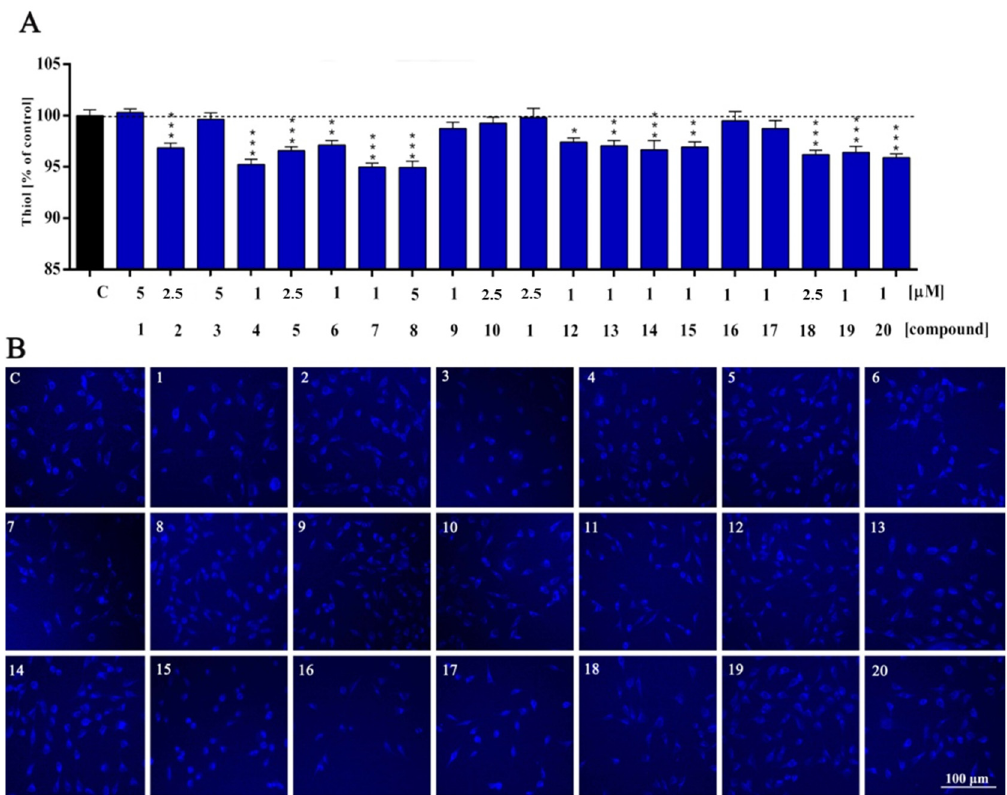
Figure 6. Reduced glutathione (thiol) level of HT-22 cells treated with compounds 1–20 ( A ) for 48 h and representative images ( B ). All experimental groups were compared using one-way ANOVA of variance with Dunnett’s post hoc test; mean ± SD, n = 9. Statistically significant results are displayed as: * p < 0.05; ** p < 0.01; *** p < 0.001. Blue fluorescence—DAPI. Magnification of the objective lens 10×.